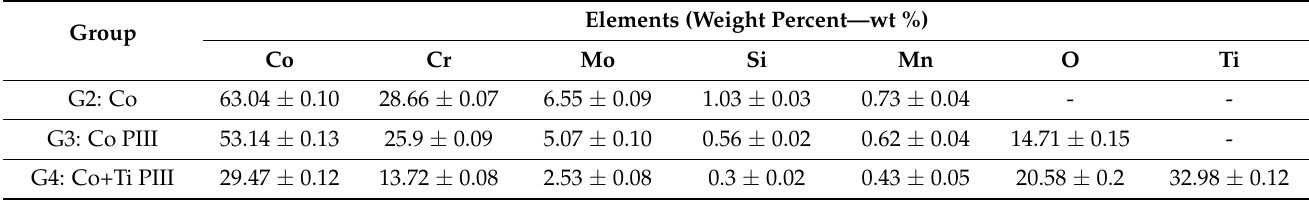
Table 2. Surface chemical composition obtained from the energy-dispersive X-ray spectroscopy (EDX) analysis. Elements (Weight Percent—wt %) Group